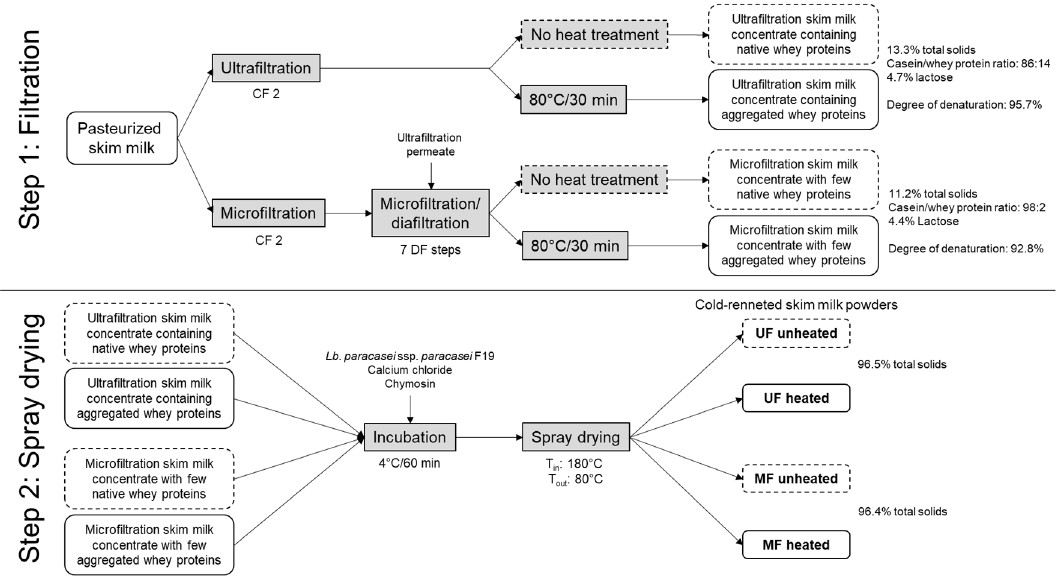
Figure 1. Processing scheme for cold-renneted skim milk powder production. CF: concentration factor; DF: diafiltration; UF: ultrafiltration; MF: microfiltration.